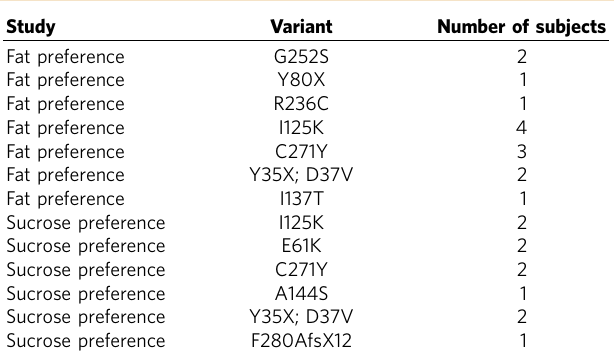
Table 2 | MC4R variants carried by individuals taking part in these